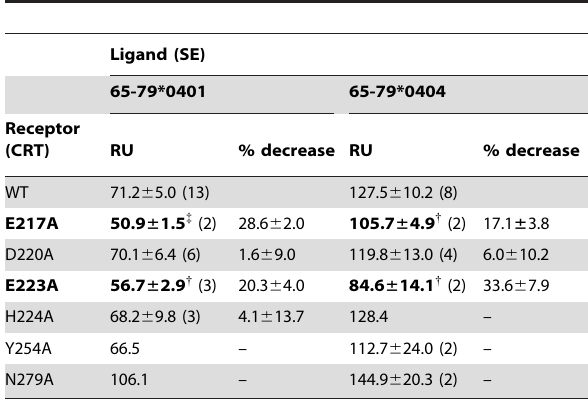
Values are shown as mean 6 SEM. Significantly lower interactions are shown in bold. { , p , 0.05; { , p , 0.005. The figures in parentheses represent the number